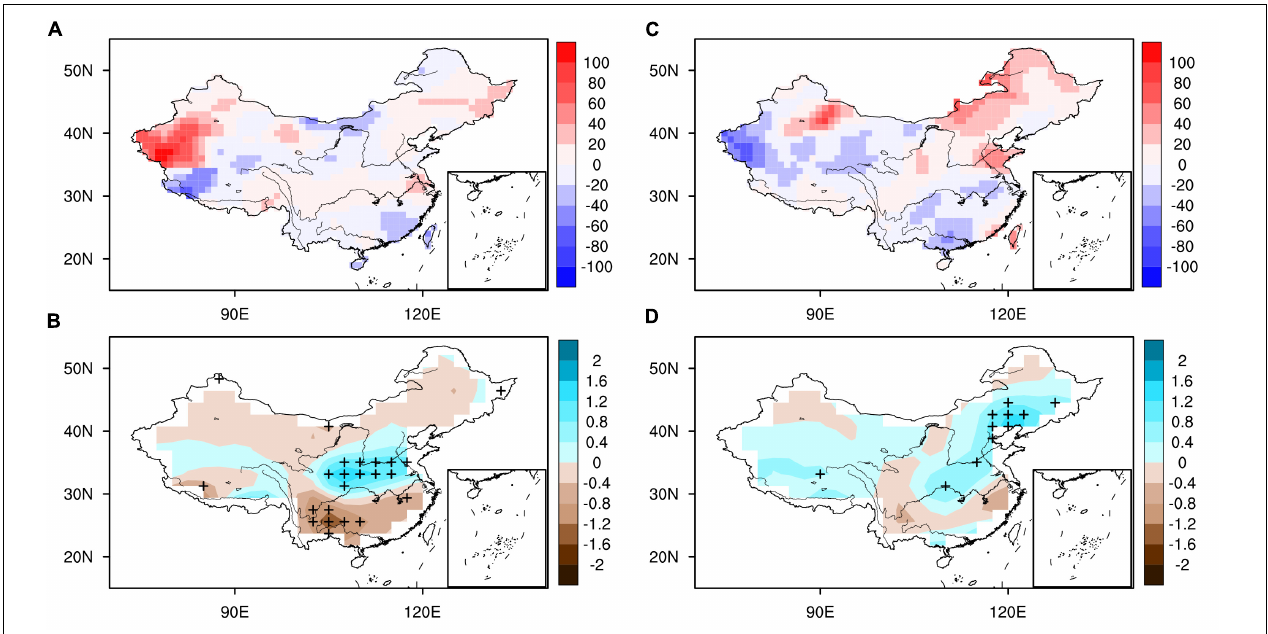
FIGURE 7 | The percentage distributions of precipitation anomalies (%; compared to 1981–2010 climatology) based on the daily precipitation data collected from 756 observation stations of the Chinese Meteorological Administration in a typical year of the Tibetan Plateau (TP) heavier snow cover in (A) southern TP (1987, which corresponds to weak Asian summer monsoon) and (C) northern TP (1990, which corresponds to strong Asian summer monsoon). The patterns of summer precipitation anomalies (sensitive experiments minus control experiment; mm/day) in Eastern China (EC) from a (B) sensitive experiment with heavier snow in southern TP and a (D) sensitive experiment with heavier snow in northern TP. The anomalies over the region with black crosses are statistically significant at 90% level under Student’s t test (Wang C. et al., 2017).